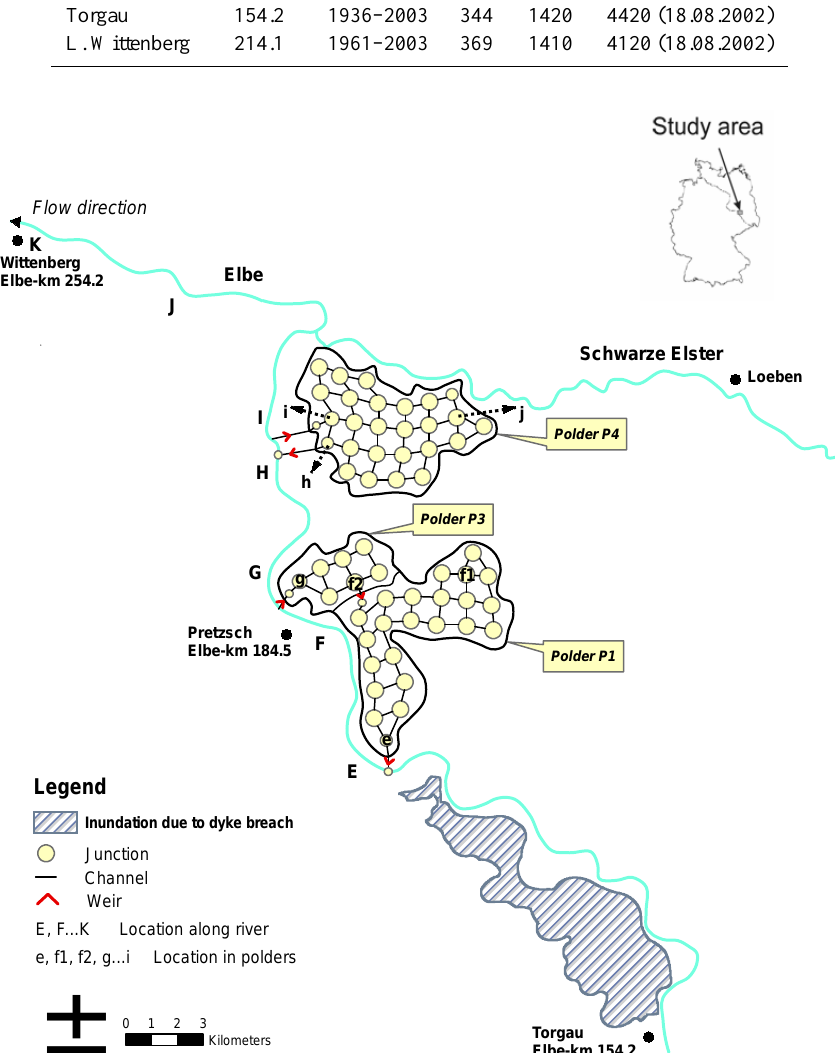
Fig. 3. The study area of polders with the discretisation by junctions and channels and a possible inundated